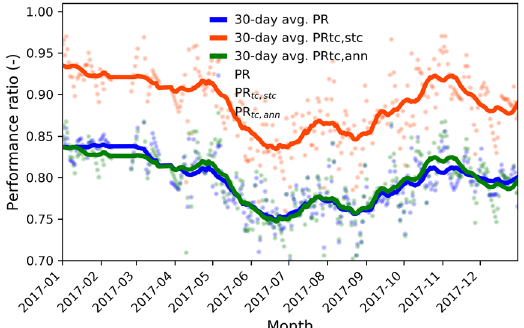
Figure 5. Daily performance ratio of a p-Si system in Cirata in 2017.